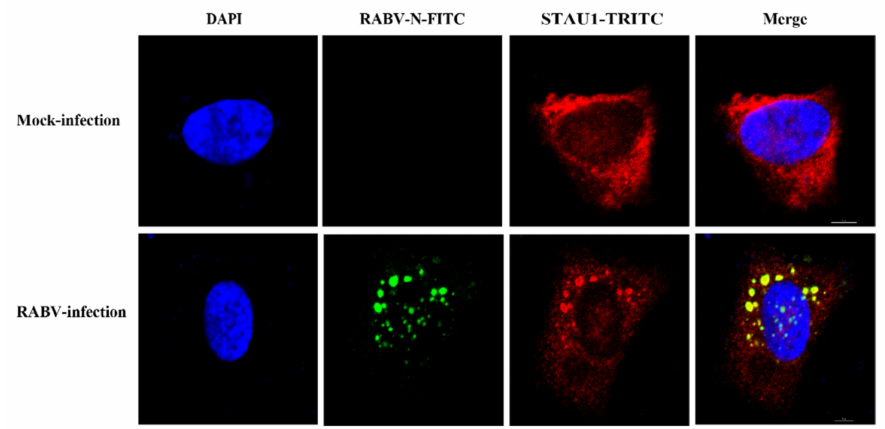
Figure 1. Subcellular distribution of STAU1 in RABV infected SH-SY5Y cells. Note: The scale is 5 µ